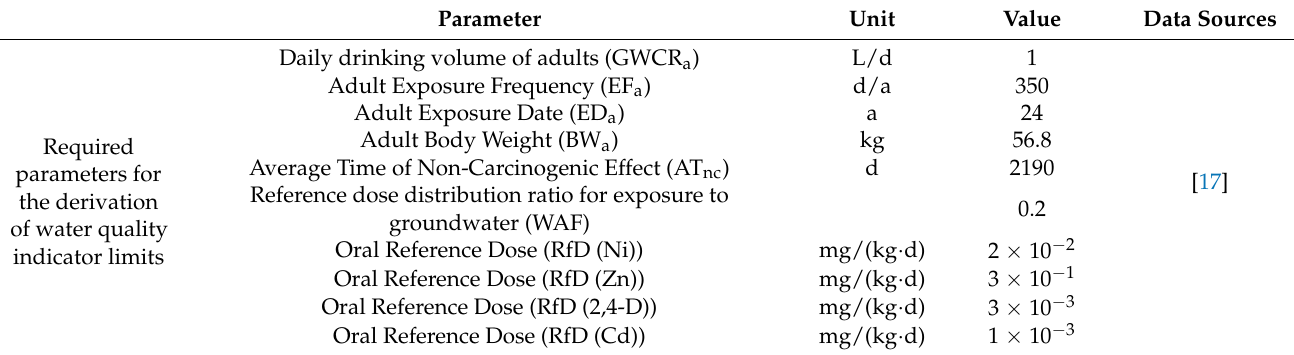
Table 2. Main parameters and values of BFD simulation